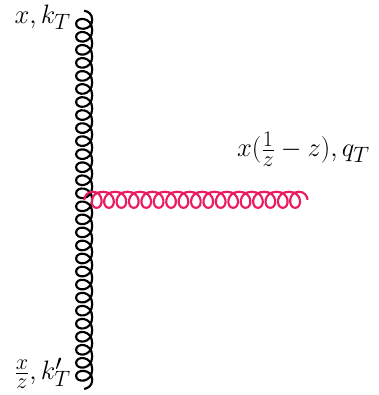
Fig. 1 Schematic diagram representing gluon emission in the BFKL chain. x and x / z arethelongitudinalmomentumfractionsofthetarget’s momentum carried by the exchanged gluon. k T , k (cid:4) two-dimensional transverse momenta of the exchanged gluons and the emitted gluon